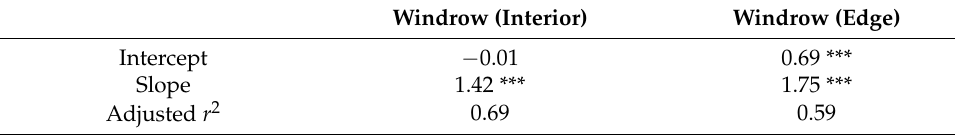
Table 2. Linear regression of percent damage of windrow samples on huller